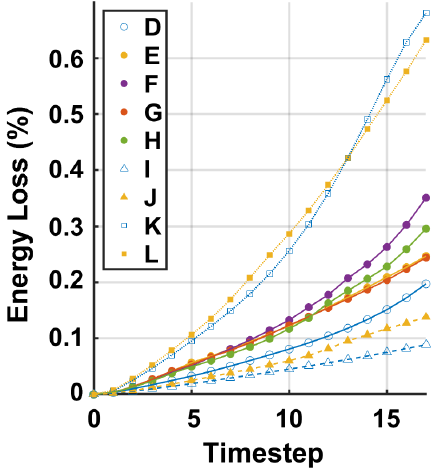
ð x; y Þ field as a function of wave FIG. 9. Fourier transform of E FIG. 10. Energy loss normalized to the laser pulse energy at y vector k 0 and y at initialization (a) and after propagating 4.33 ps initialization plotted over time. Hollow marker objects indicate (b-f). Panels (b – e) show results using different cluster parameters the use of a uniform plasma, filled marker objects indicate a and panel (f) shows data from a uniform simulation. The cluster cluster plasma. Triangles represent simulations using half the peak density (normalized to n ) is 5 (b), 2.5 (c), 1.25 (d), and plasma density ( 0 . 002 n ). Squares represent the use of laser cr cr 0.75 (e). The relative normalized number density of clusters in the pulses of only 18.9% of the energy (compared to all other simulation box is 0.15 (b), 0.17 (c), 0.6 (d), and 1 (e) giving the simulations) within a halved pulse length of (15 fs) and reduced same average electron charge density. The wave vector for a laser spot-size. The parameters of each simulation can be found in of wavelength λ 0 ¼ 800 nm is k 0 ¼ 7 . 85 × 10 6 m − 1 in vacuum Table I. Here, one time step corresponds to 0.25 ps in simulation ¼ 0 . 004 n D and to 0.26 ps in all other and k 0 ¼ 7 . 84 × 10 6 m − 1 in a plasma of n . e cr